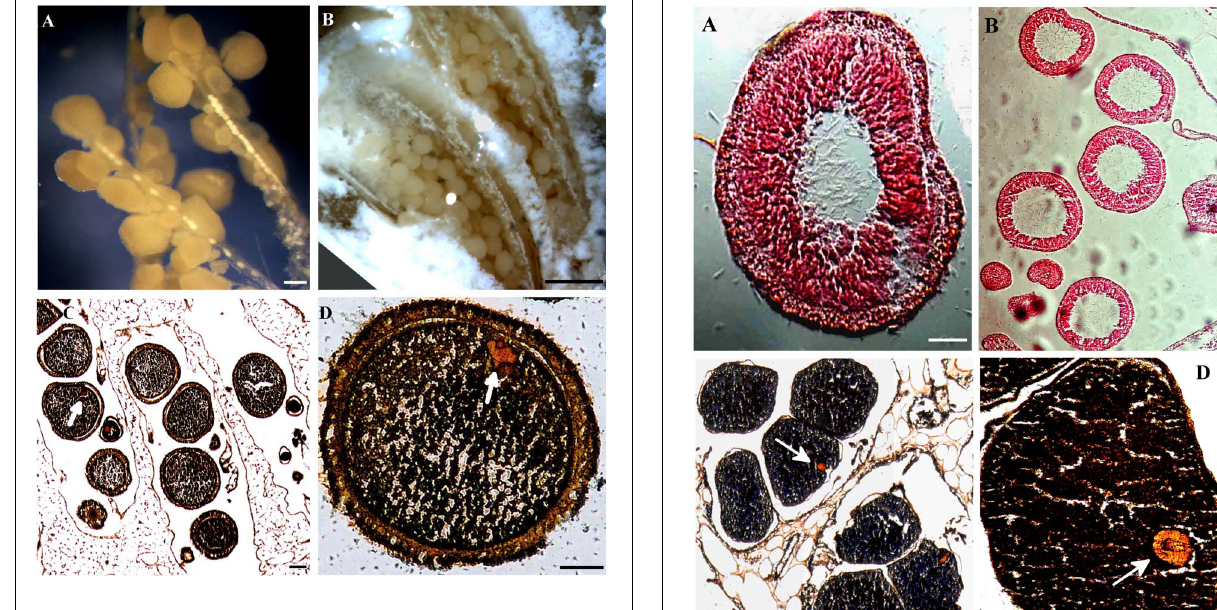
FIGURE 2 | Gonads of upper MCE Ovabunda spp. (A) Spermaries on mesenteries (July 2017). (B) Male colony with spermaries filling polyp cavities (July 2016). (C) Sagittal section in female colony featuring ripe and immature oocytes (August 2016). (D) Cross-section of mature oocyte. White arrow points toward the nucleus (August 2016). Scale bars = 100 µ m. FIGURE 3 | Gonads of upper MCE Rhytisma fulvum fulvum (A) Sagittal